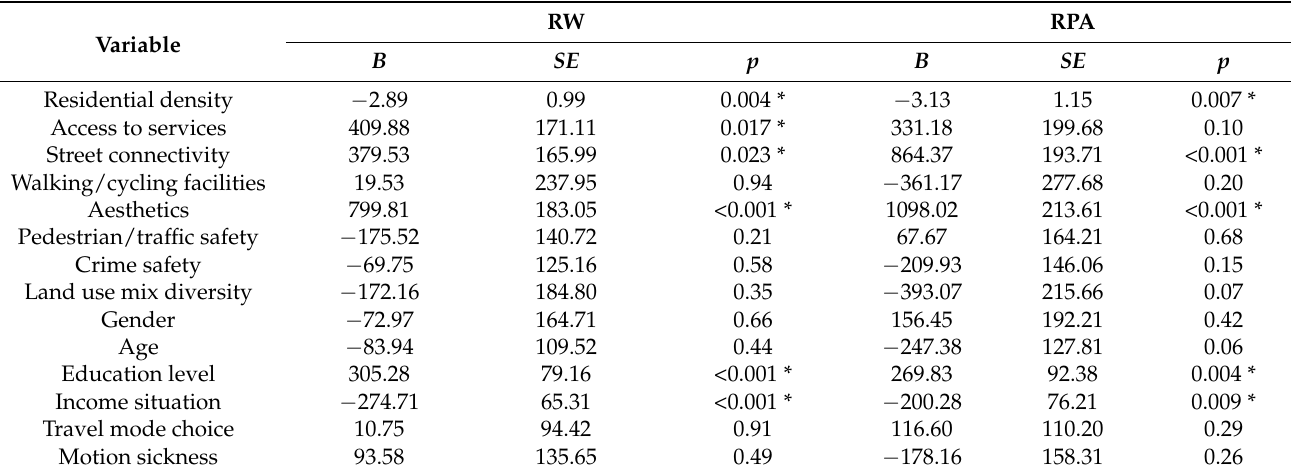
Table 4. Association of built environment with older people’s RW and RPA when demographic variables as a covariable in the city of